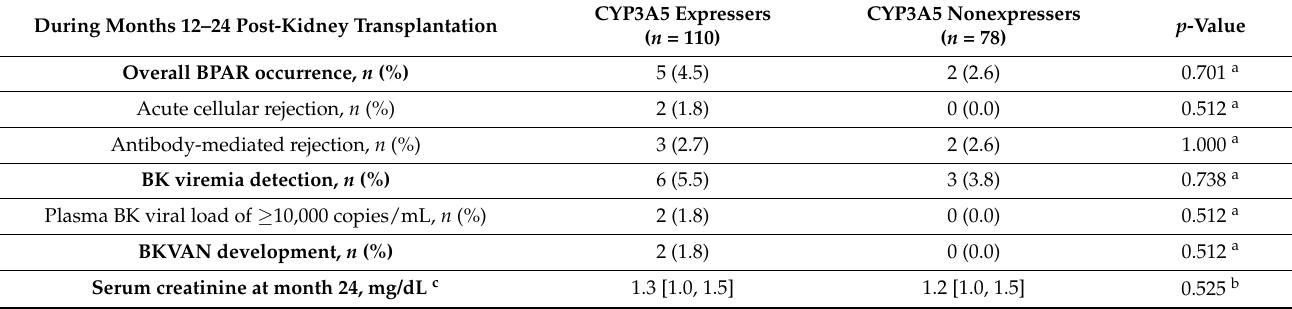
Table 4. Biopsy-proven acute rejection, BK viral infection, and serum creatinine at 24 months post- kidney